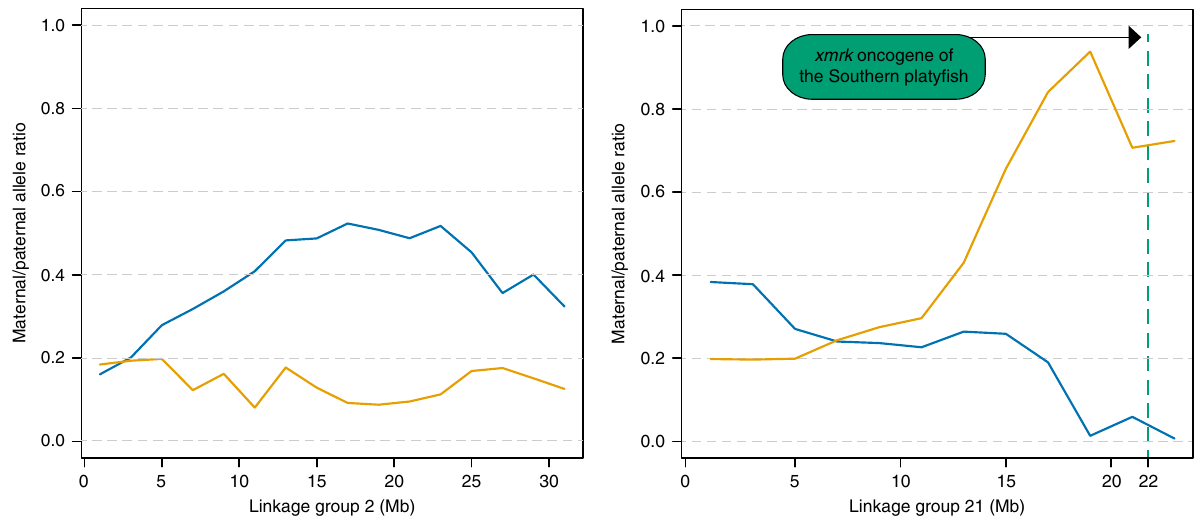
Fig. 3 Parental allele ratios in the fi rst generation backcross. Maternal and paternal allele ratios in BC 1 _wt (blue line) and BC 1 _pigm (orange line) on LG2 and LG21. The location of the melanoma gene ( Xmrk ), linked to the pigmentation genes, in LG21 is